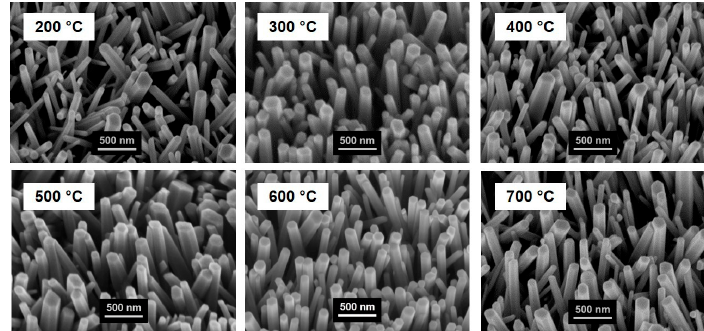
Figure 2. Inclined-view (30°) SEM graphs of ZnO NRs grown on S/A SLs at different pre- annealing temperatures from 200 °C to 700 °C.